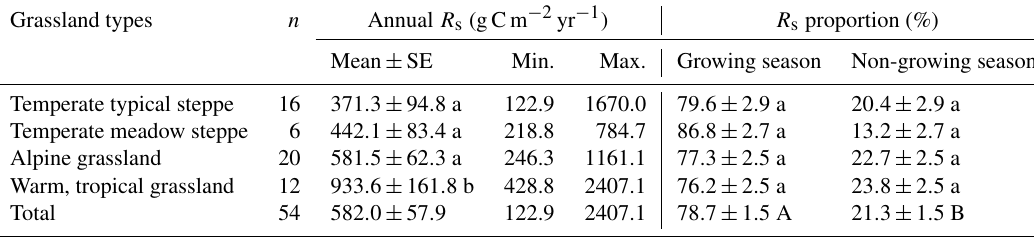
Table 1. The annual soil respiration ( R s ) and the proportions of growing-season and non-growing-season R s to annual R s in different grassland ecosystems across China. There was no sample for annual R s in temperate desert steppe, so the data were not presented in this table. The different lowercase letters in each column indicate the significant difference at p = 0 . 05, and different uppercase letters indicate the significant difference between the growing and non-growing season at p = 0 . 001; n represents the number of